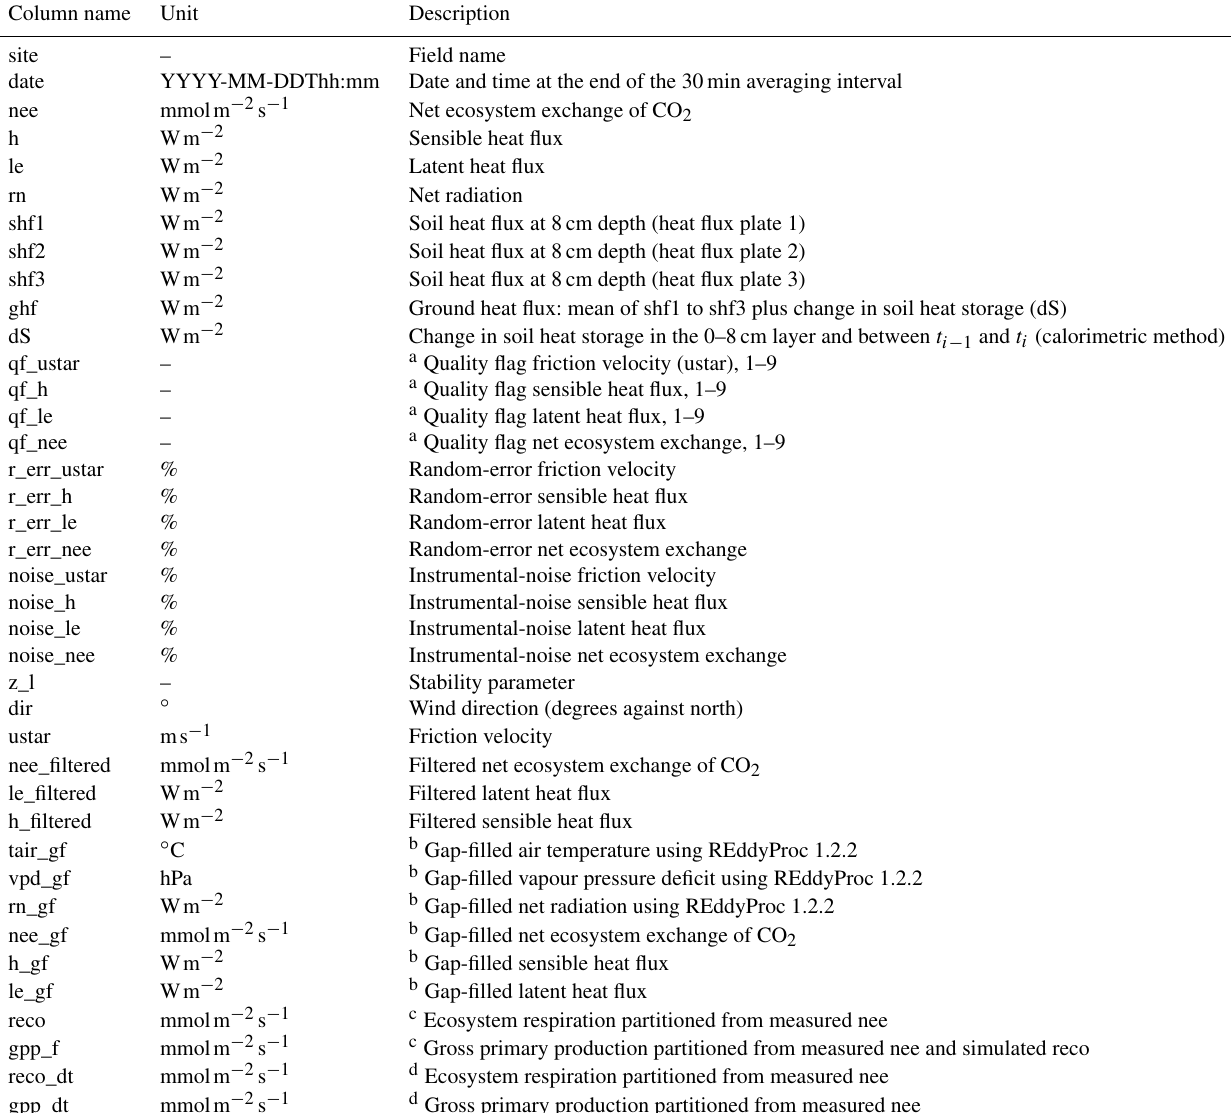
Table 12. Determined variables and description of the eddy-covariance measurement data files (flux_data.csv). For the variables nee_filtered, le_filtered and h_filtered data points were removed according to the following rule: for the respective quality flag > 6 and those measured values which were > 5 times the median of the previous 4d were discarded. The Max Planck Institute (MPI) REddyProc R tool was used to gap-fill and for partitioning net ecosystem exchange (nee) into ecosystem respiration and gross primary